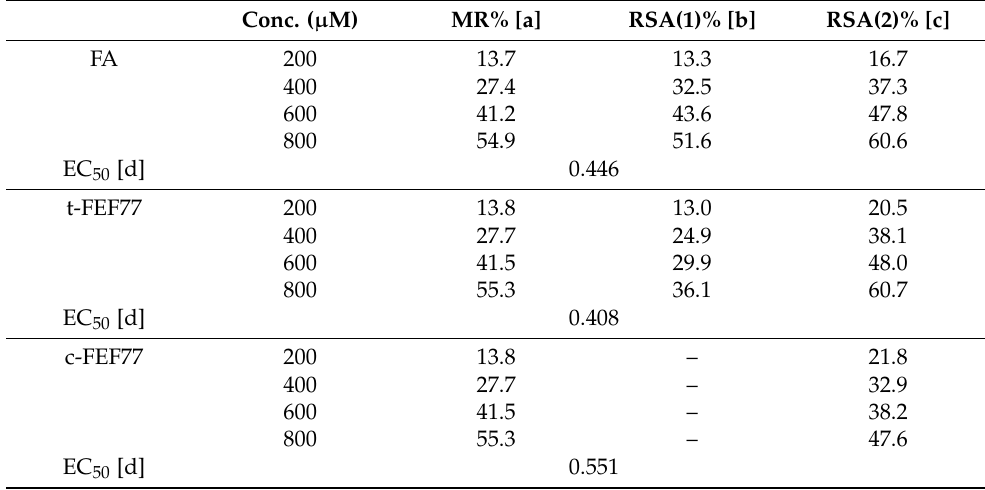
Table 1. Results of DPPH assays on compounds FA, t-FEF77, and